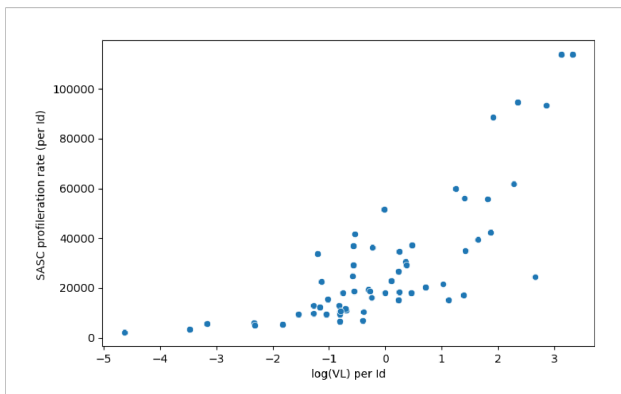
FIGURE 6 The proliferation rate of SASC increases with the presence of a higher viral load. Correlation coef fi cient is 0.84 and p-value of 2.97×10 -15